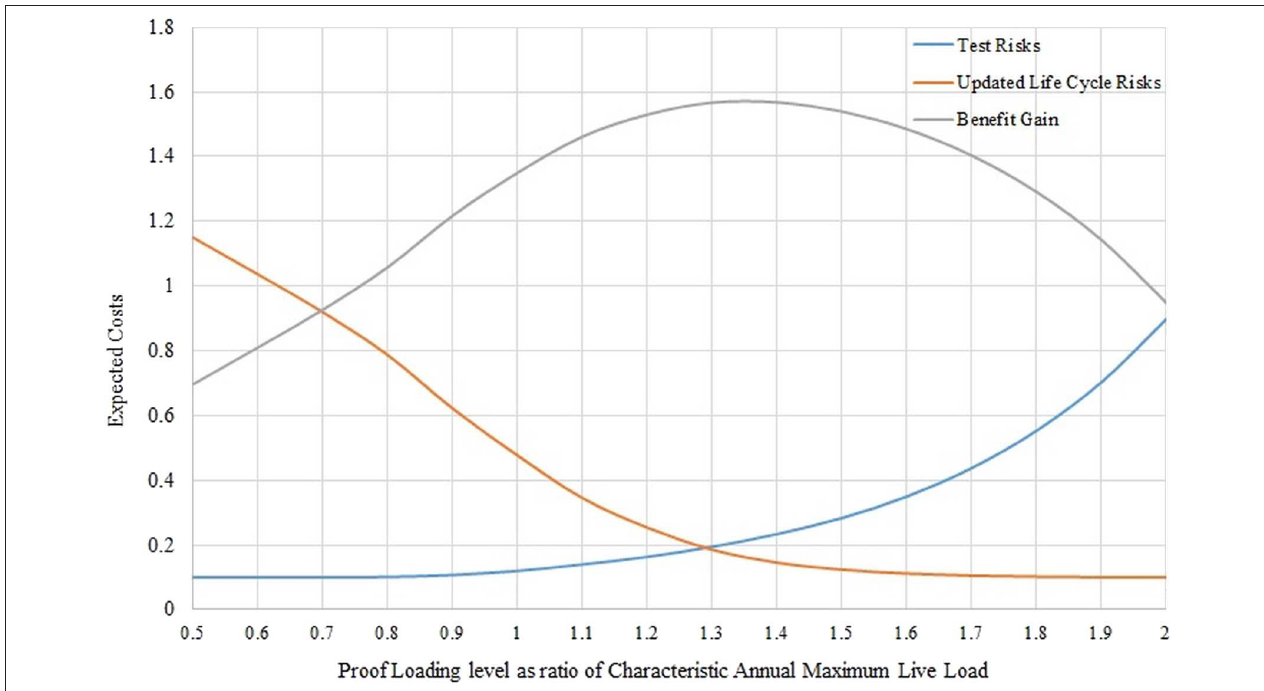
FIGURE 7 | Illustration of expected costs (test risks in blue and life cycle risks in orange) and benefit gain (in gray) from the proof loading as a function of the proof load